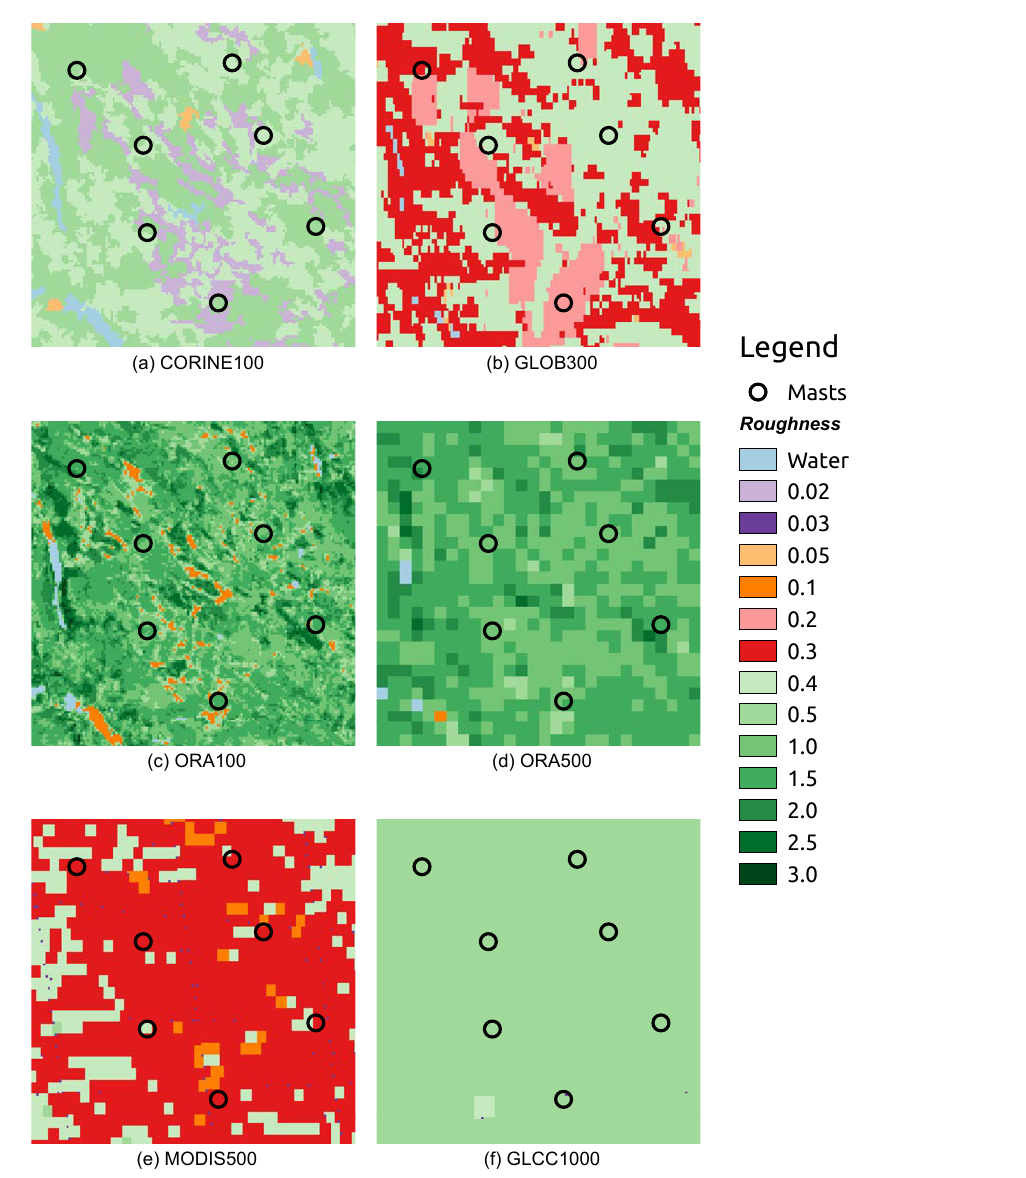
Figure 2. Roughness maps from land use datasets, and from ORA at 100 and 500m resolutions, coloured by roughness values. Open circles show mast